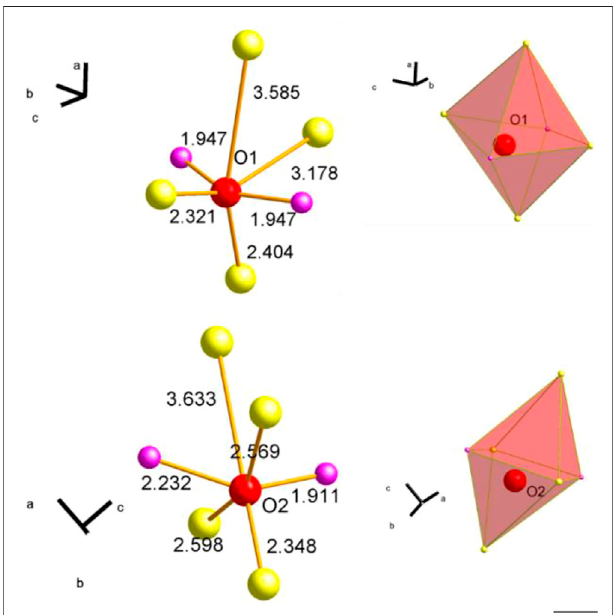
FIGURE 7 | Representation of the two different lattice oxygen (red balls) O1 (A) andO2 (B) centeredbetweennextneighboringMnatoms(purpleballs) and Sm atoms (yellow balls). Numbers next to the illustrated connection betweenoxygen and metal atom (orange) givethe distance between the atoms. Corresponding octahedral polyhedra are depicted on the right.